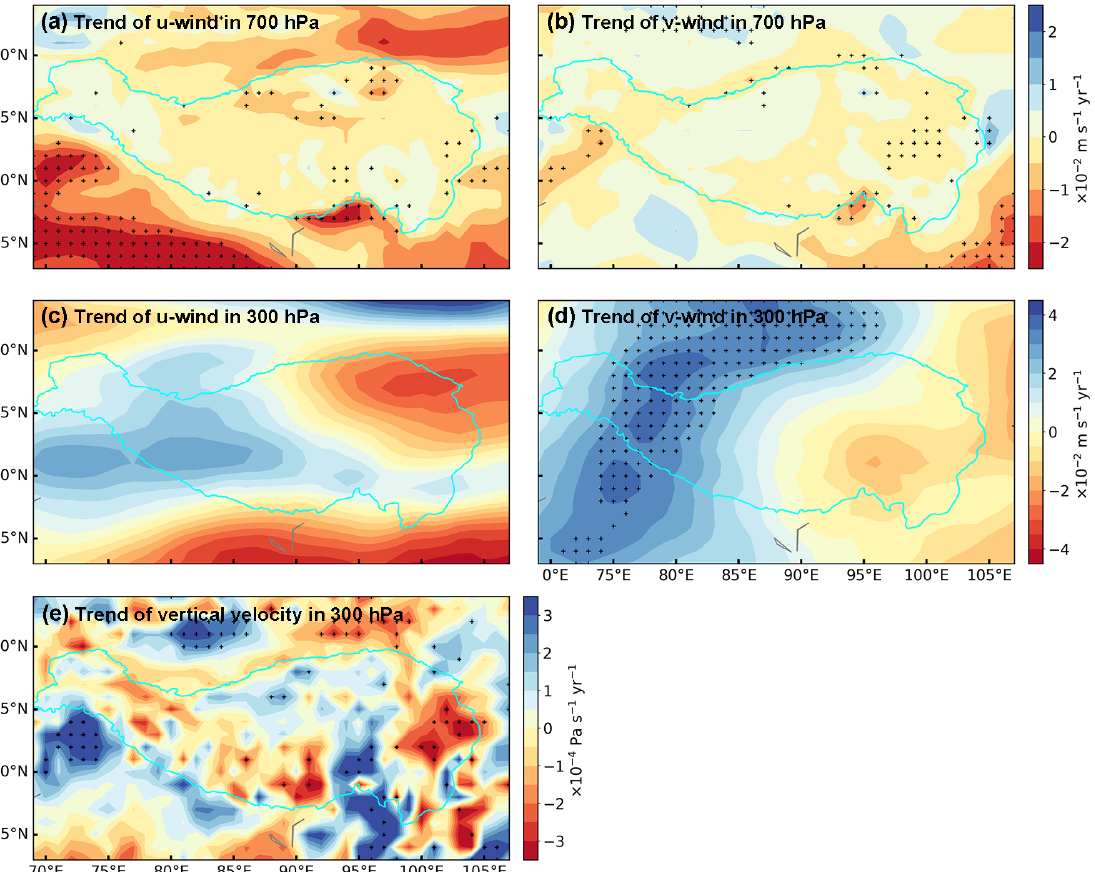
Figure 7. Long-term trends of annual ( a ) zonal ( u ) wind at 700hPa (positive denotes enhanced eastward wind), ( b ) meridional ( v ) wind at 700hPa (positive denotes enhanced northward wind), ( c ) zonal ( u ) wind at 300hPa, ( d ) meridional ( v ) wind at 300hPa and ( e ) vertical velocity at 300hPa (positive denotes decreased upward motion) around the TP region during 1979–2015. Stippling indicates regions with statistically significant trends ( p< 0 . 05). Note the negative values of vertical velocity indicate upward motion.